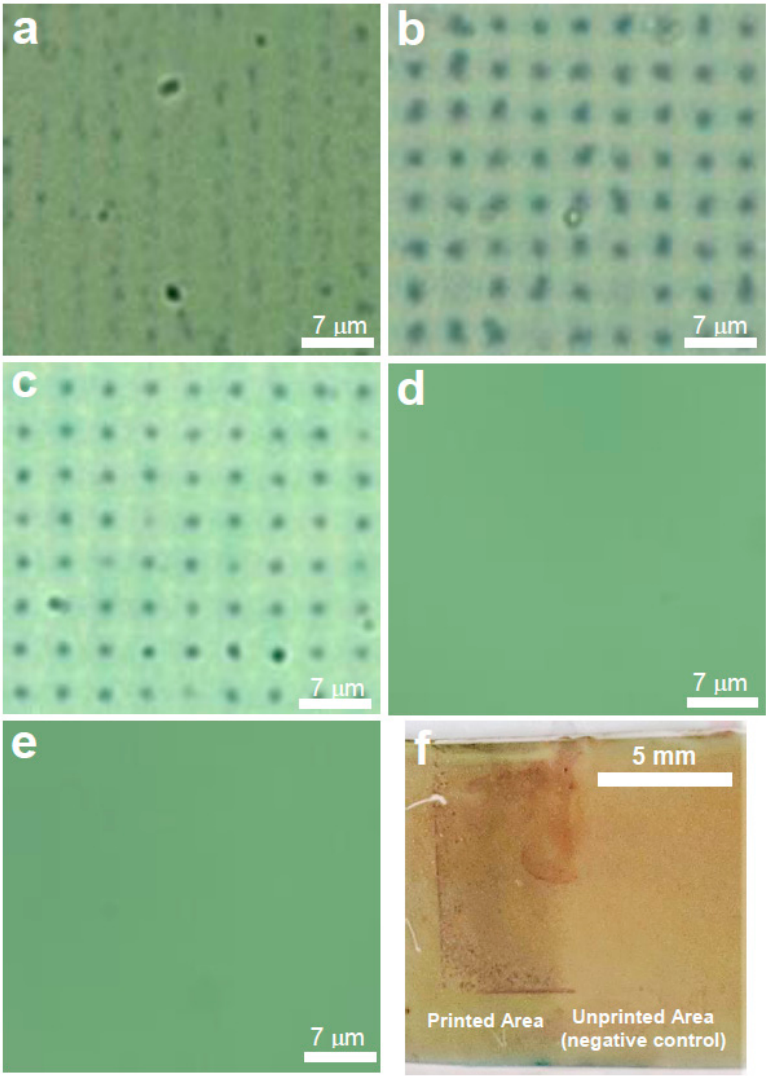
Figure 3. Representative optical microscopy images (40 × magnification) for immobilisation experiments on arrays with capture DNA-AuNPs and analyte. In ( a ), 10 pmol of target ssDNA was hybridised with the DNA-AuNPs at room temperature (RT) overnight and applied to the DNA array for 3 h at RT. In ( b ), 10 pmol of target ssDNA was hybridised with the DNA-AuNPs at RT overnight and applied to the DNA array for 3 h at 30 °C. In ( c ), 5 pmol of target ssDNA was tested using the same conditions as ( b ). In ( d ) and ( e ), only DNA-AuNPs or only 10 pmol target ssDNA was added, respectively, using the same conditions as ( b ). Figure ( f ) shows a photographic image of the slide post hybridisation using the conditions in ( b